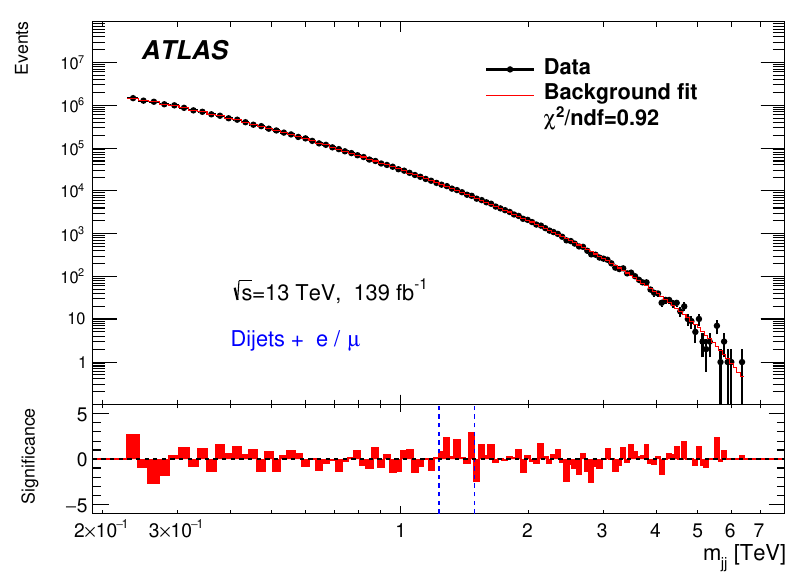
Figure 2. Dijet invariant-mass distribution from the 2015{2018 data, from events with a high- p T lepton ( e + (cid:22) combined). The distribution is calculated from the two leading jets selected from events with at least one isolated lepton with p ‘ > 60 GeV. Also shown is the result of the (cid:12)t T with the (cid:12)ve-parameter background function. The lower panel shows the bin-by-bin signi(cid:12)cances of deviations from the background hypothesis. The largest deviation reported by BumpHunter is indicated by the vertical dashed lines. The global p -value of this deviation is